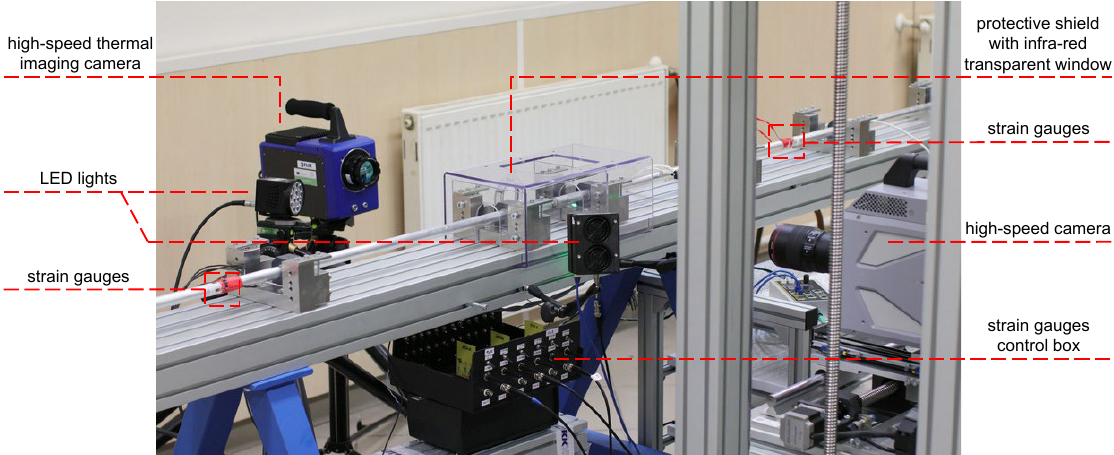
Figure 4. The experimental set-up consisting of the high-speed thermal-imaging camera, the high- speed visible-spectrum camera, and the illumination